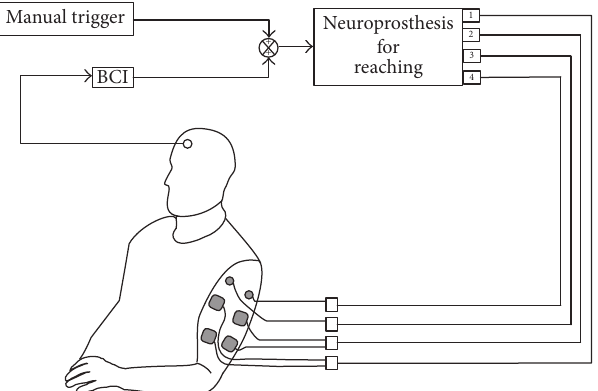
Figure 4: Illustration of the integrated BCI and FEST system. The electrical stimulation was delivered with a four-channel neuropros- thesis for reaching which could be triggered with a BCI or a manual switch. The BCI used the signal from a single electrode (positioned at location Fz of the 10–20 EEG electrode placement system), and the manual switch allowed for activating the stimulator whenever the BCI failed to identify the intention to move (note that ground channels for the anterior and posterior deltoid stimulation channels are not